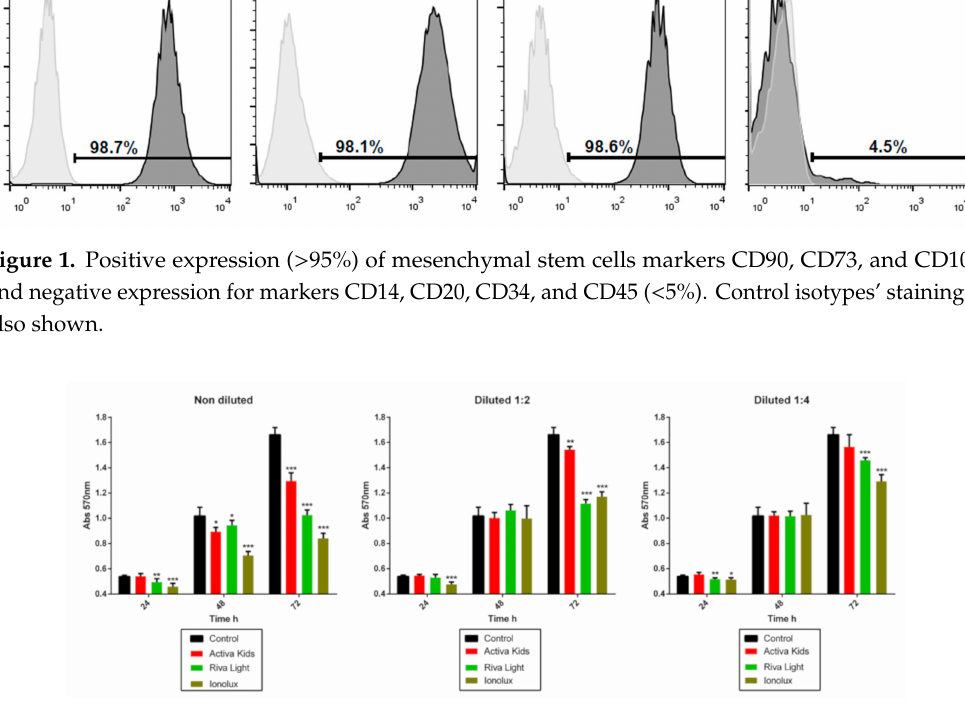
Figure 2. Human dental pulp stem cells’ (hDPSCs’) metabolic activity after stimulation with ACTIVA Kids BioACTIVE Restorative (Activa), Ionolux, and Riva light Cure UV (Riva), as determined by anMethylthiazolyltetrazolium(MTT)assay. Itwasperformedwiththreereplicates. Observedmetabolic activity di ff erences are shown as * p < 0.05; ** p < 0.01; *** p < 0.001,